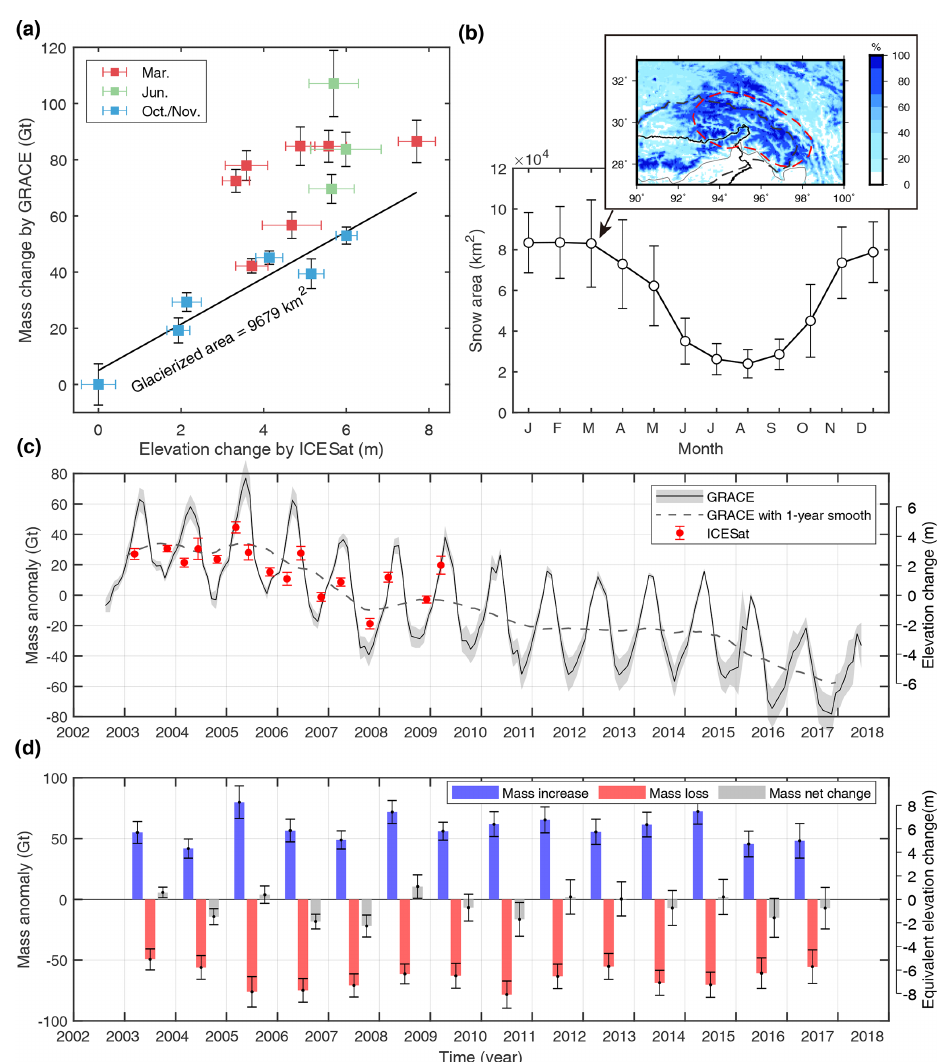
Figure 6. GS mass balance in the SETP. (a) GS mass change by GRACE as a function of elevation change from ICESat. The values are anomalies relative to the minimum in October 2007. (b) Seasonal snow coverage changes. The error bars are calculated by the dispersions in the same month in the years from 2003 to 2016. The coverage in March is given in the inset. The dashed red outline marks the region used for the calculation of snow area. (c) Time series of GS mass change estimated by GRACE and glacier mass change by ICESat. The glacierized area of 9679km 2 is used to convert thickness change into mass change. (d) Annual mass increase and decrease from 2003 to 2016 by